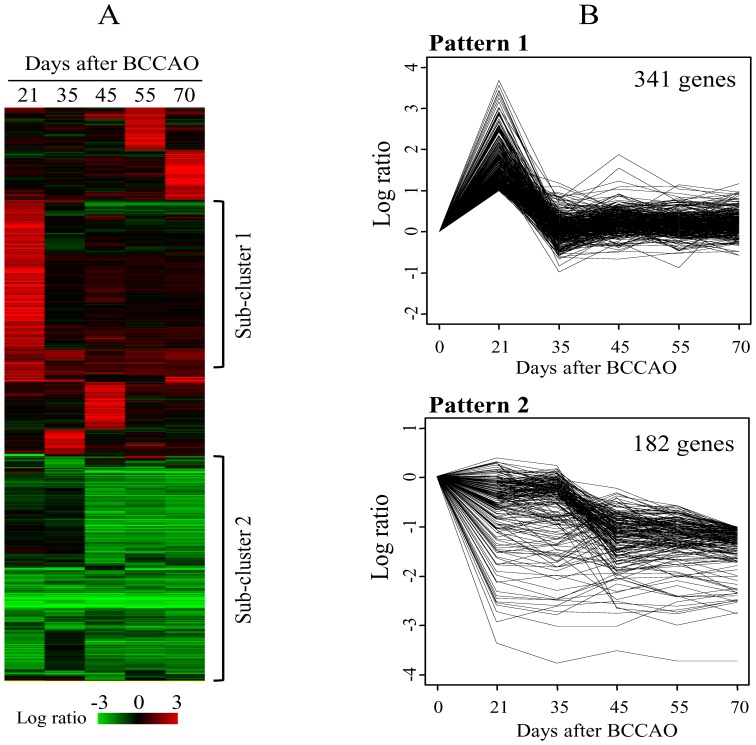
Temporal expression of genes in the hippocampus after BCCAO.(A) A total of 1,583 genes that showed at least 2-fold ratio variation when compared with those of the sham group in at least 1 of 5 samples from the 21, 35, 45, 55 and 70 days time points after BCCAO were hierarchically clustered. Two sub-clusters were indicated as Sub-cluster 1 and Sub-cluster 2. The columns represent individual samples, while the rows represent genes. The red and green colors reflect high and low expression levels, respectively, as indicated by the scale bars. (B) Temporally altered genes were classified using the Short Time-series Expression Miner (STEM) analysis into two patterns (false discovery rate [FDR]<0.001). Pattern 1 was composed of 341 genes and Pattern 2 was composed of 182 genes.